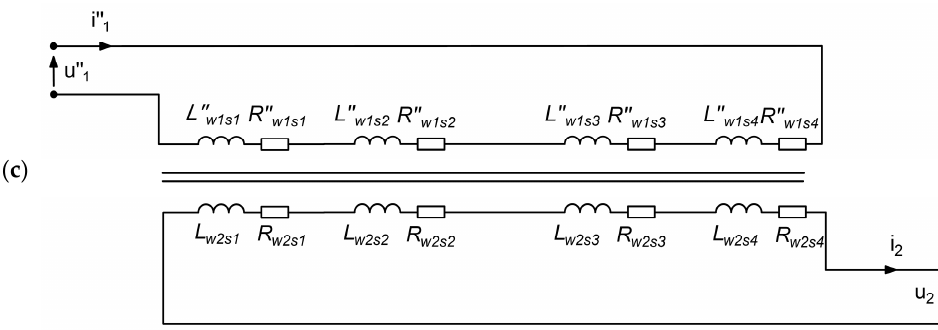
Figure 3. Examples of primary and secondary winding section connections: ( a ) serial-parallel, primary and parallel secondary winding sections, ( b ) parallel primary and parallel secondary winding sections, ( c ) serial primary and serial secondary winding sections.